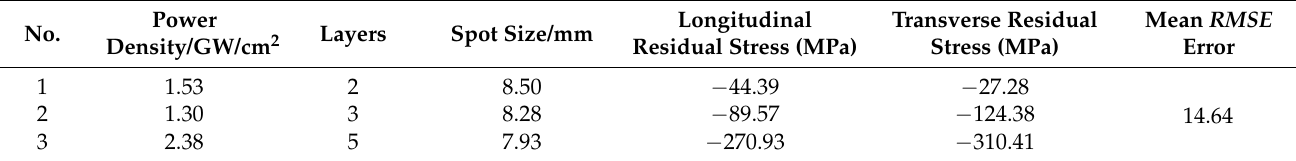
Table 10. Optimised input parameters using the GA to obtain the desired parameters in Table 9 with two degrees of freedom (relative depth and number of layers fixed as input